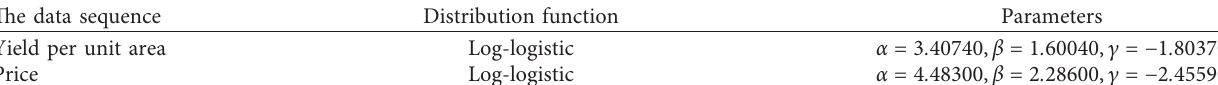
Table 2: Distribution functions and parameters of jujube yield per unit area and price in Aksu region.